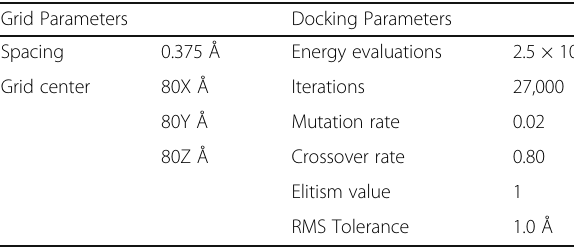
Table 1 Docking parameters used for docking studies